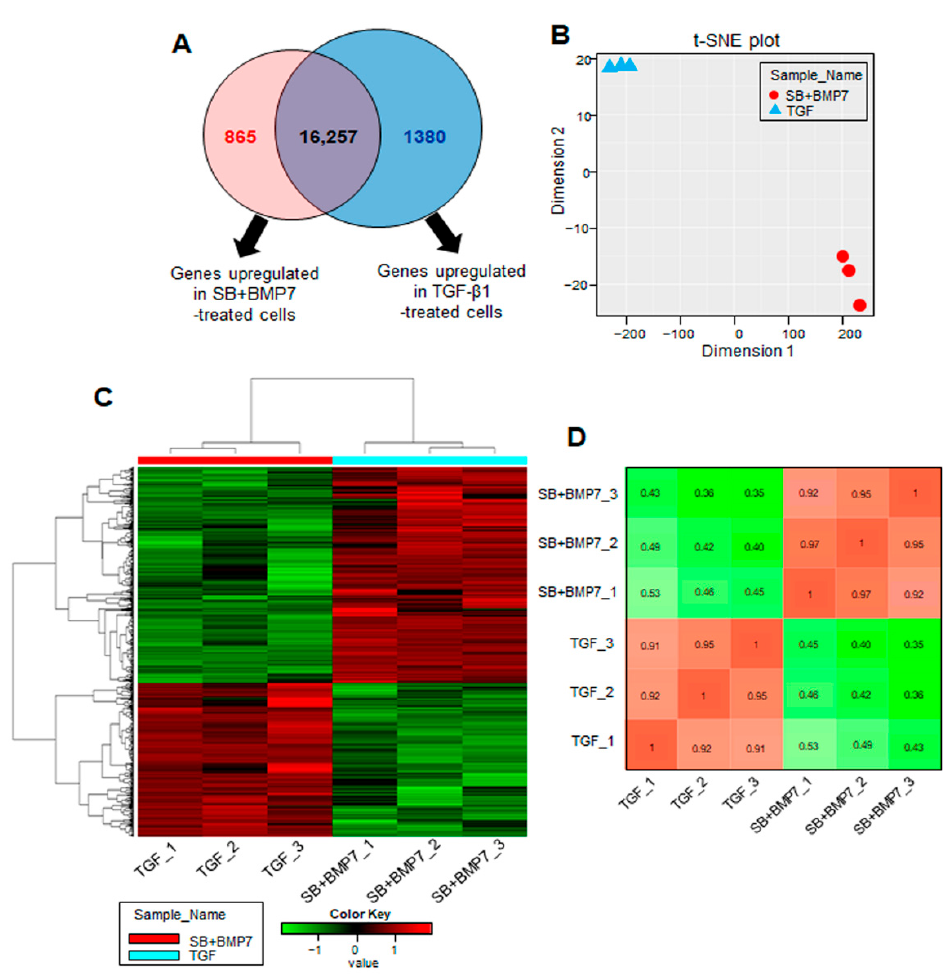
Figure 3. Transcriptome analysis of hPDLCs treated with TGF- β 1 and co-treated with SB431542 and BMP7. ( A ) The number of upregulated genes identified in the comparison set, SB+BMP7 vs. TGF- β 1. Overlapping areas in the Venn diagram represent genes common to all comparison groups. The size of the circle is proportional to the number of DEGs in the comparison set. ( B ) The MDS plot shows how similar and close the transcriptome changes of each sample are based on log 2 FPKM values. ( C ) Hierarchical clustering heatmap for 2245 DEGs (865 DEGs upregulated in SB+BMP7-treated cells and 1380 DEGs upregulated in TGF- β 1-treated cells) are represented. There is a histogram in the color key showing the number of expression values within each color bar. ( D ) The Euclidean distances were calculated between each sample and the colors indicate the distances. The gradient from red (high) to green (low) indicates relative similarity of gene expression between the